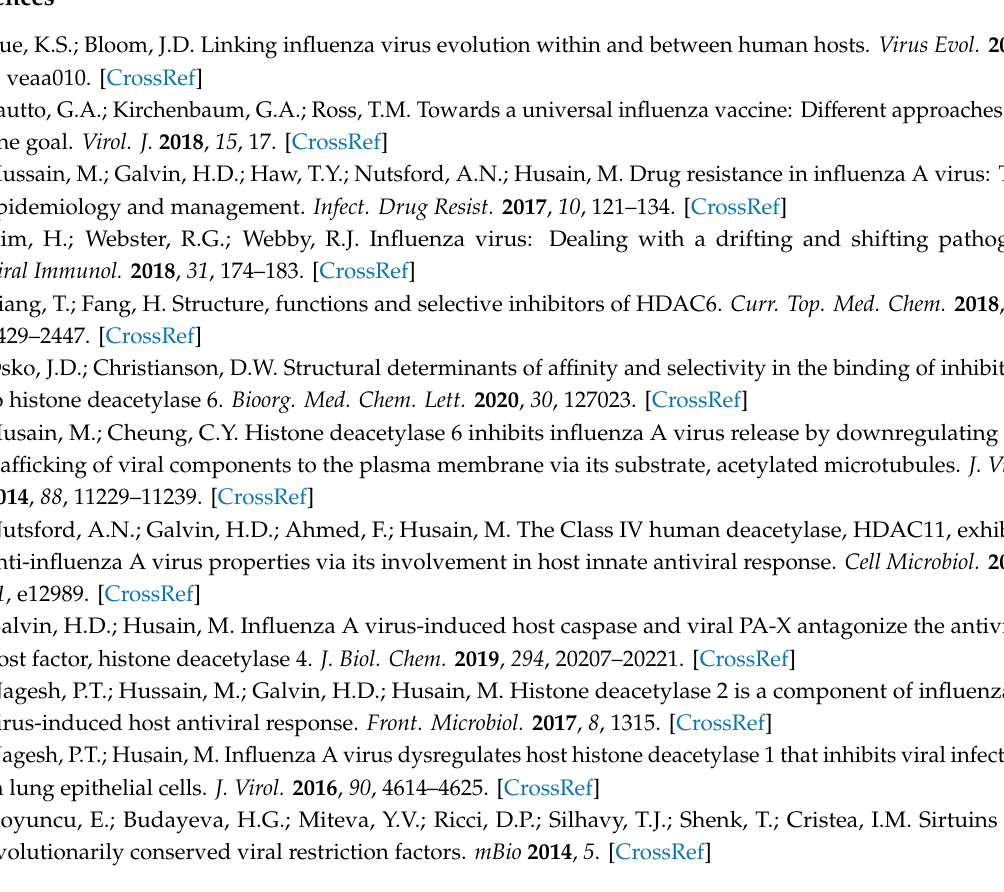
Figure S1: Confirmation of HDAC6 knockour mouse genotype and phenotype; Figure S2: Type I interferon (IFN) and CD80 , CXCL10 and IL15 genes are downregulated in HDAC6 KO mouse lungs after influenza (IAV) infection; Figure S3: Relative expression of innate immune response genes in WT and KO mouse lungs after IAV infection; Figure S4: Percent body weight of WT and KO male mice inoculated with 50 pfu dose of